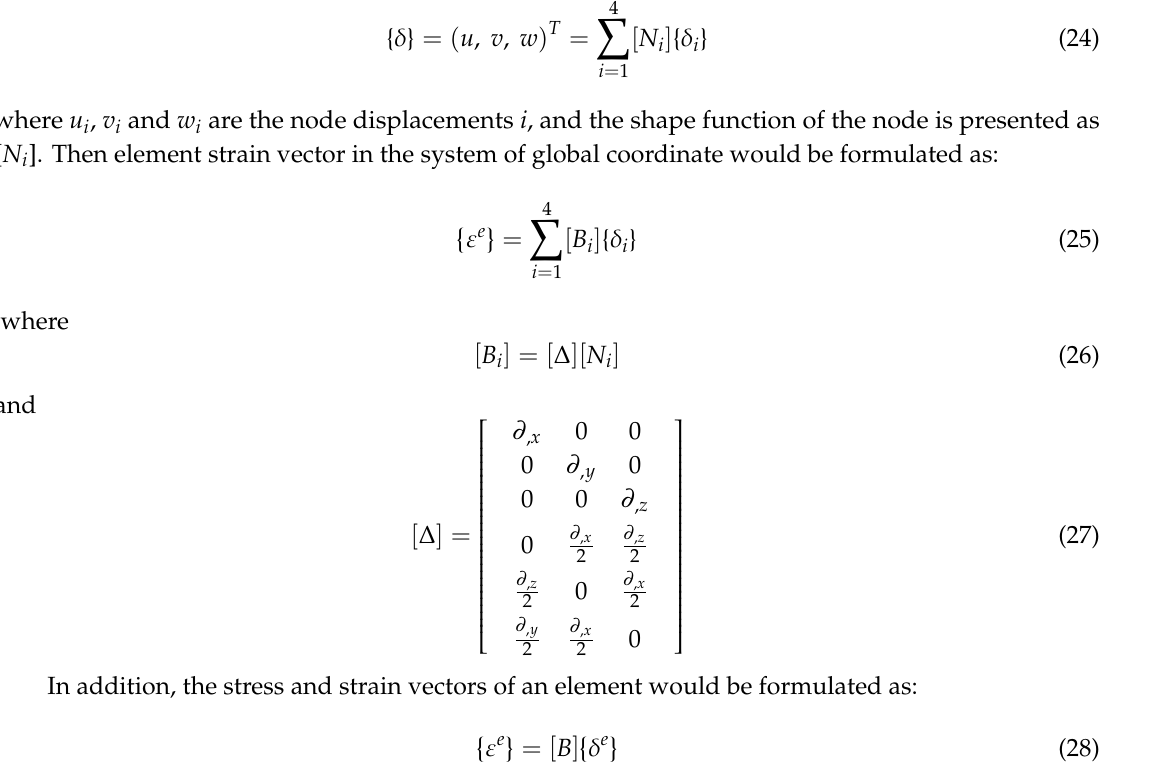
(cid:112) 2 ρ ( 1 + υ ) / E ) of the isotropic flat curved panel.